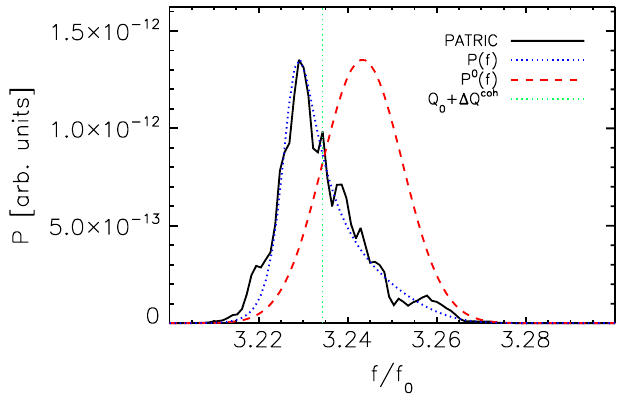
FIG. 6. (Color) Schottky spectrum from the PATRIC simulation with a constant imaginary impedance corresponding to U 1 . The dashed red curve represents the noise spectrum for (cid:4) 0 with its maximum adjusted to the U U coh The vertical green line represents the shifted coherent tune (cid:8) (cid:2) Q coh . Q coh (cid:4) Q 0